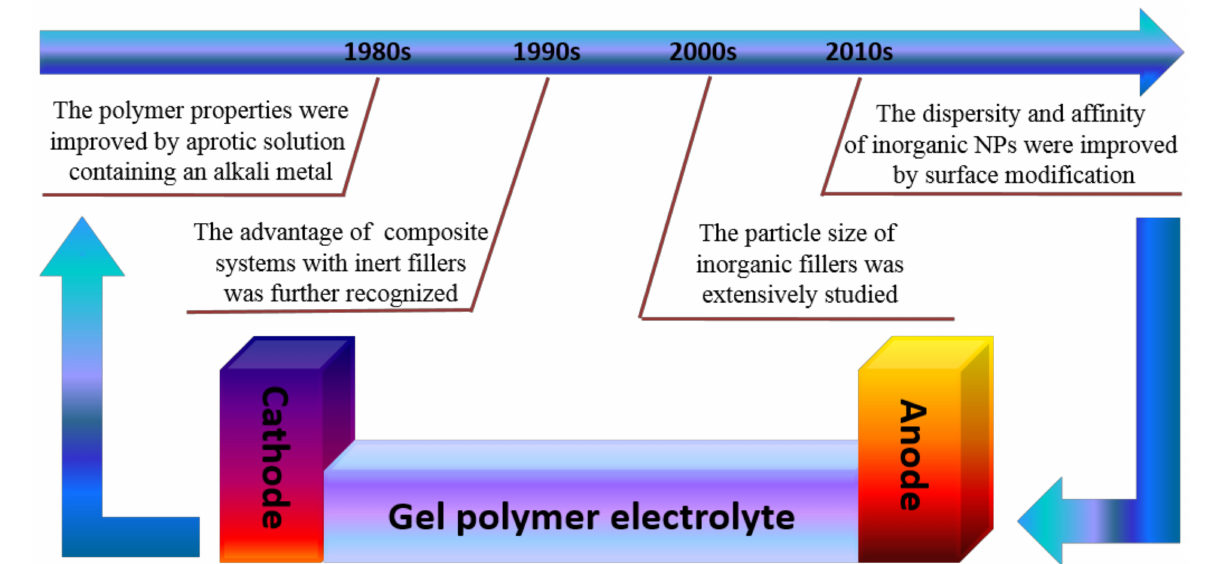
Figure 3. Historical overview of the developments of inorganic fillers in